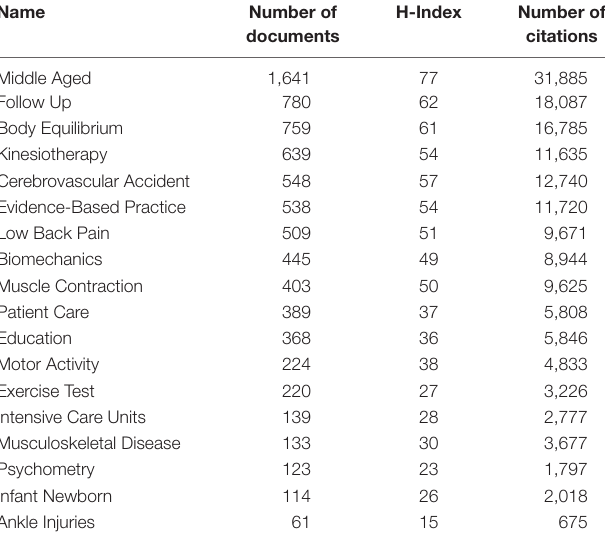
Table 3 | Bibliometric indicators of period